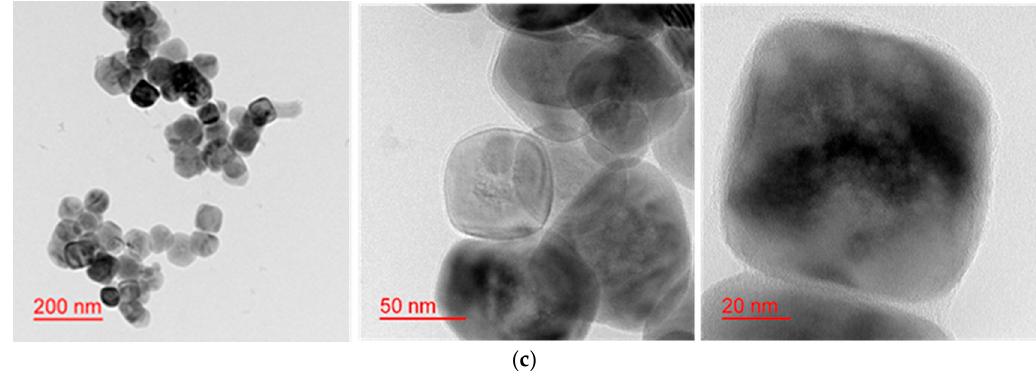
Figure 4. BT-PVP particles prepared at 230 °C for 24 h from different Ti sources, ( a ) TiCl 4 ; and ( b ) TiO 2 , respectively; ( c ) BT-PVP particles prepared by TiO 2 at 230 °C for 5 h. For the highly dispersed BT-PVP, the thickness of the PVP layer adsorbed on the BT surface was approximately 3 nm and is reduced compared to that of BT-PVP after a 5 h reaction as shown in Figure 4c. The change in the particle size in the reaction of core-oxide shell-PVP type was discussed